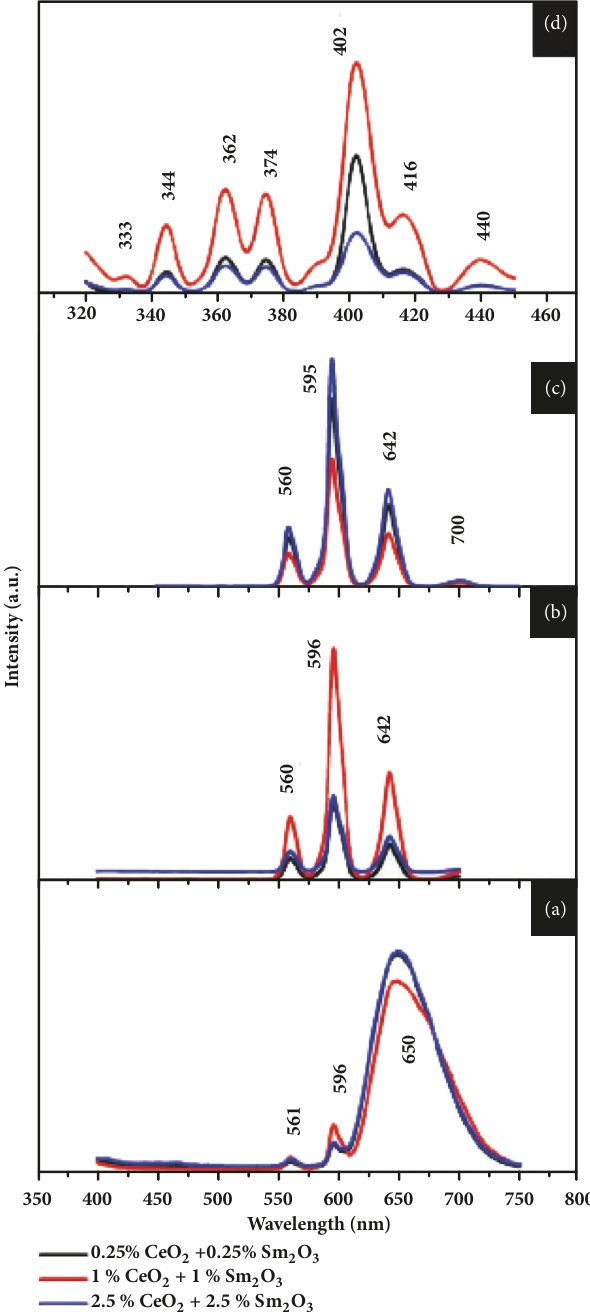
Figure 7: Photoluminescence spectra of mixed CeO 2 + Sm 2 O 3 -doped glasses: (a) emission at 𝜆 ex =290nm, (b) emission at 𝜆 ex = 365nm, (c) emission at 𝜆 ex = 402nm, and (d) excitations at 𝜆 em =